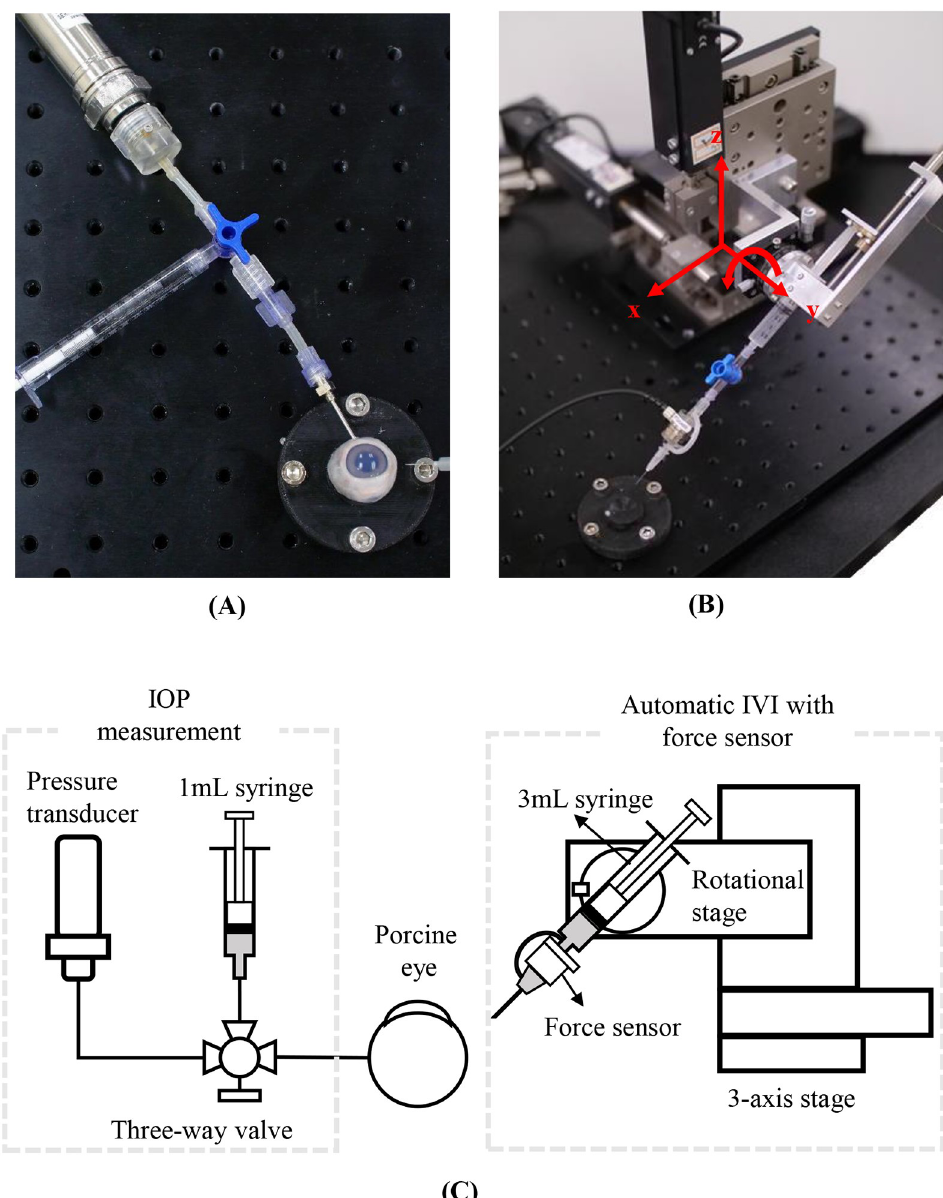
Fig 1. The automatic IVI device and experimental setup. A: A porcine eye, 17-gauge needle for IOP measurement, syringe for maintaining initial IOP, and a pressure transducer, B: an automatic injection device with a motor and ball screw, and 3-axis stage for insertion, and C: a schematic explanation of the